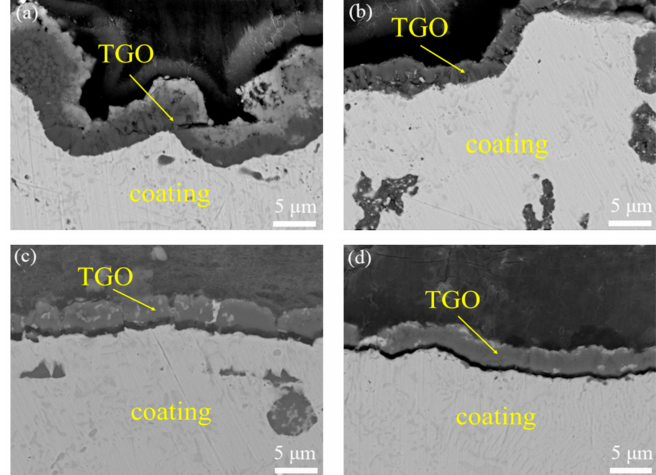
Figure 7. Structure of thermally grown oxide (TGO) on the surface of the original and vacuum heat-treated coatings after oxidation. ( a ) As-sprayed; ( b ) VHT1000; ( c ) VHT1100; and ( d )